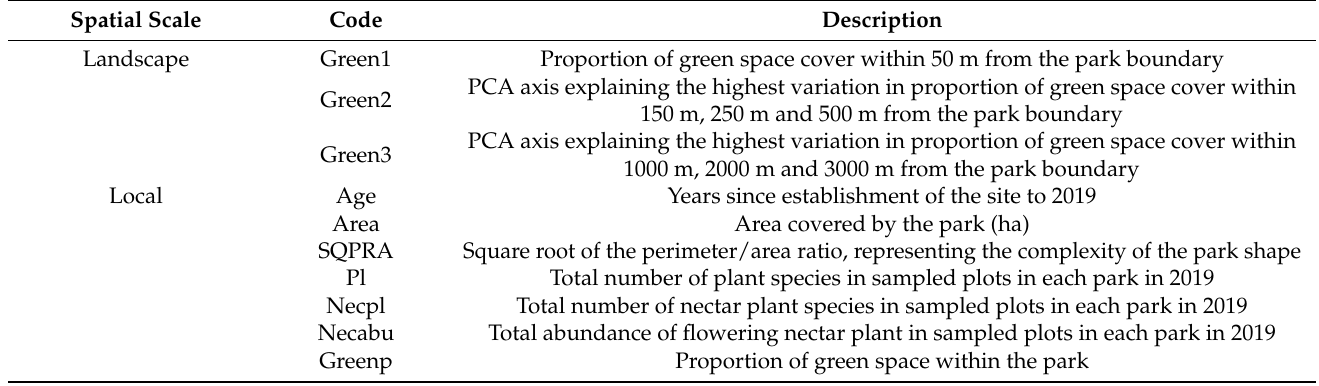
Table 2. Environmental variables were collected for each park and entered into the Generalised linear model and the redundancy